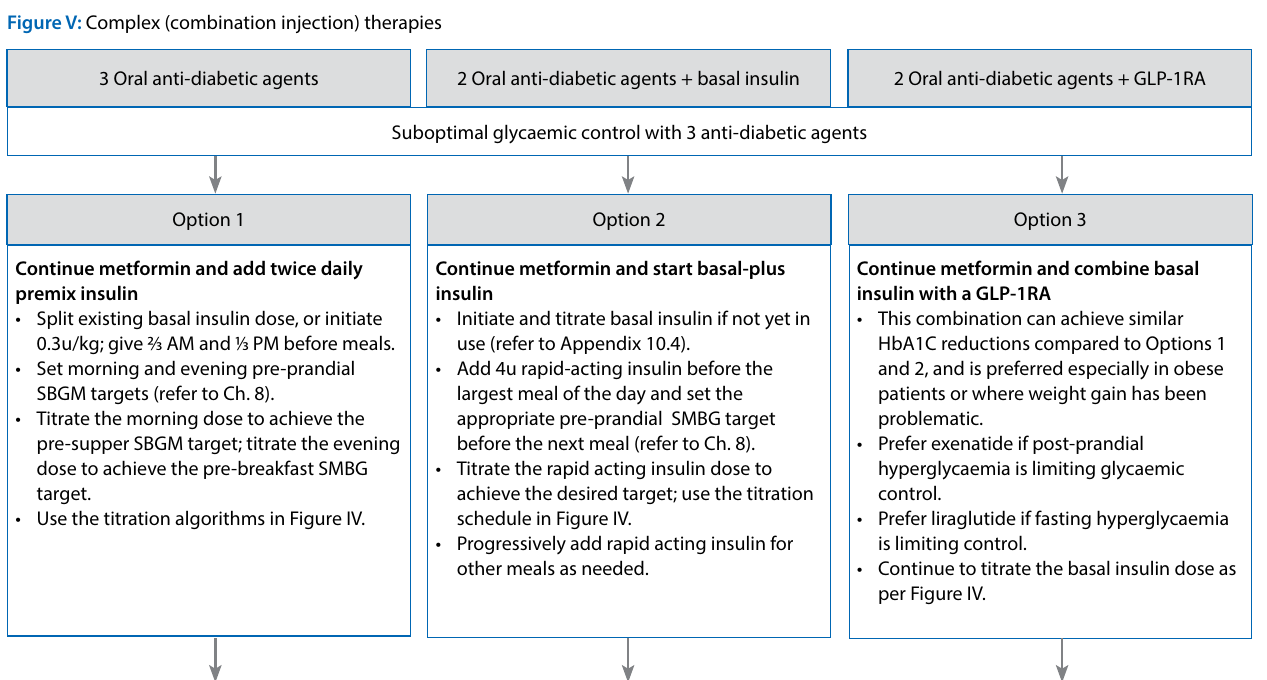
Figure V: Complex (combination injection) therapies 3 Oral anti-diabetic